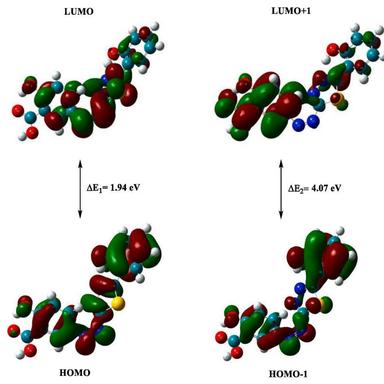
Molecular orbitals (MOs) of 2-hydroxy-5-((5-(2-hydroxyphenyl)-1,3,4-thiadiazol-2-yl) diazenyl) benzoic acid, 1b